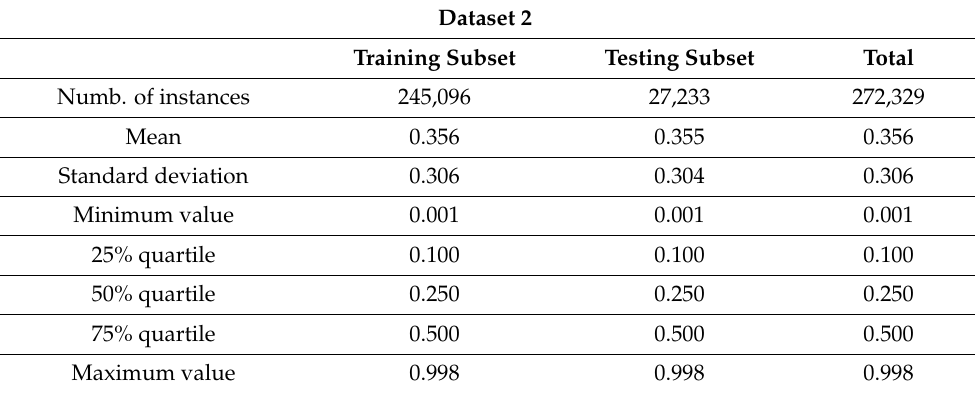
Table 4. Descriptive statistics about dataset